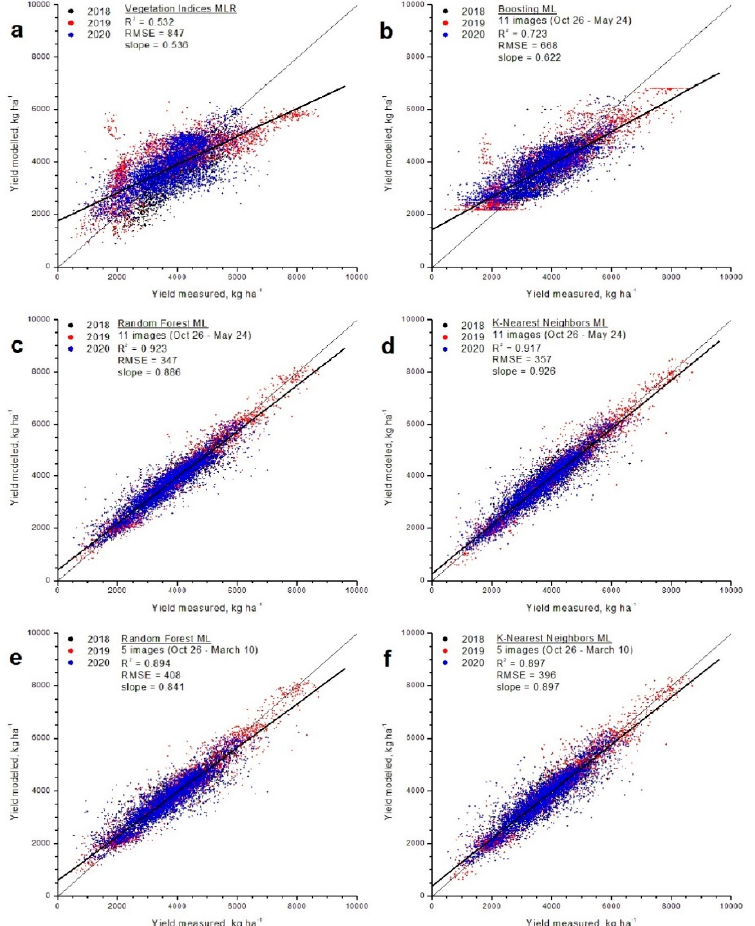
Figure 2. Relationships between measured and modeled yield based on the vegetation indices ap- proach through multiple linear regression (VI–MLR, ( a )) and machine learning approaches (ML, ( b – f )). The type of regression, the number of images per growing period used in ML regressions with the corresponding date span, the coefficient of determination (R 2 ), the root mean square error (RMSE) and the slope of the best-fit line are shown in the inserts. Data concern 66 fields during three growing periods (indicated by different colors), corresponding to 9463 pixels. The thin black line corresponds to the 1:1 line and the thick black line to the best-fit